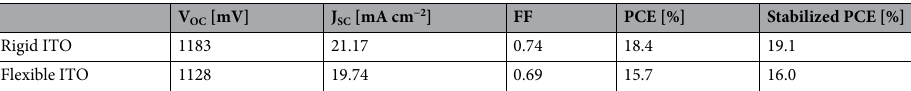
Table 2. Overview of the best device characteristics on rigid and flexible ITO